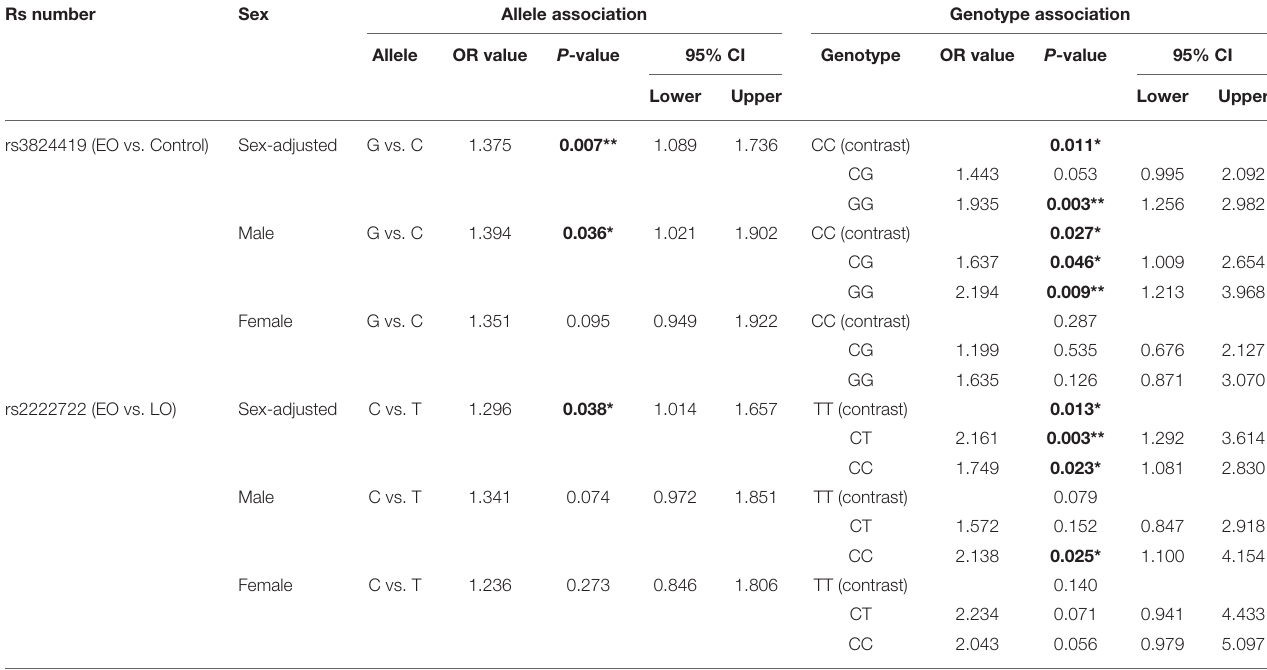
TABLE 3 | Detailed results of sex-stratified analysis of rs3824419 and rs2222722. Rs number